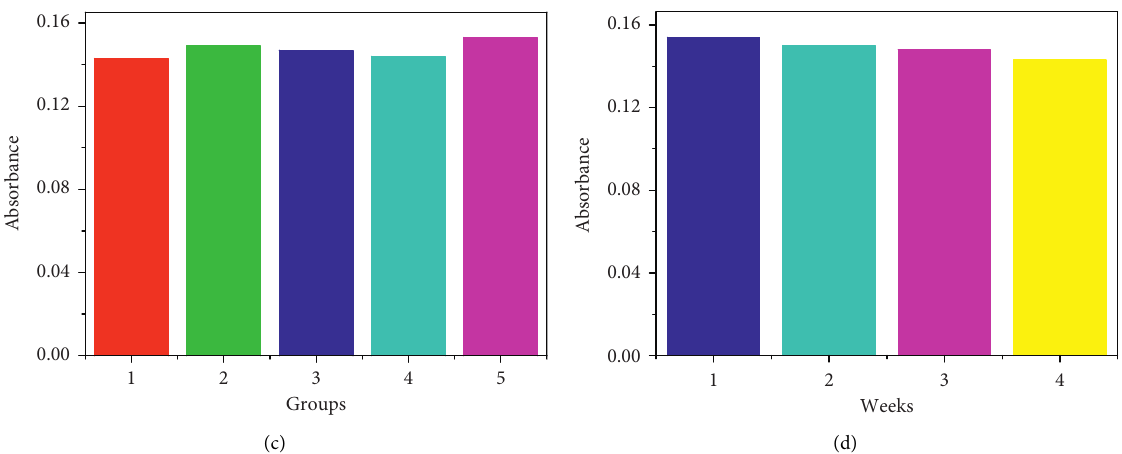
1 /CEA/Ab 2 -g-C 3 N 4 @Fe 3 O 4 for 1ng/mL CEA in